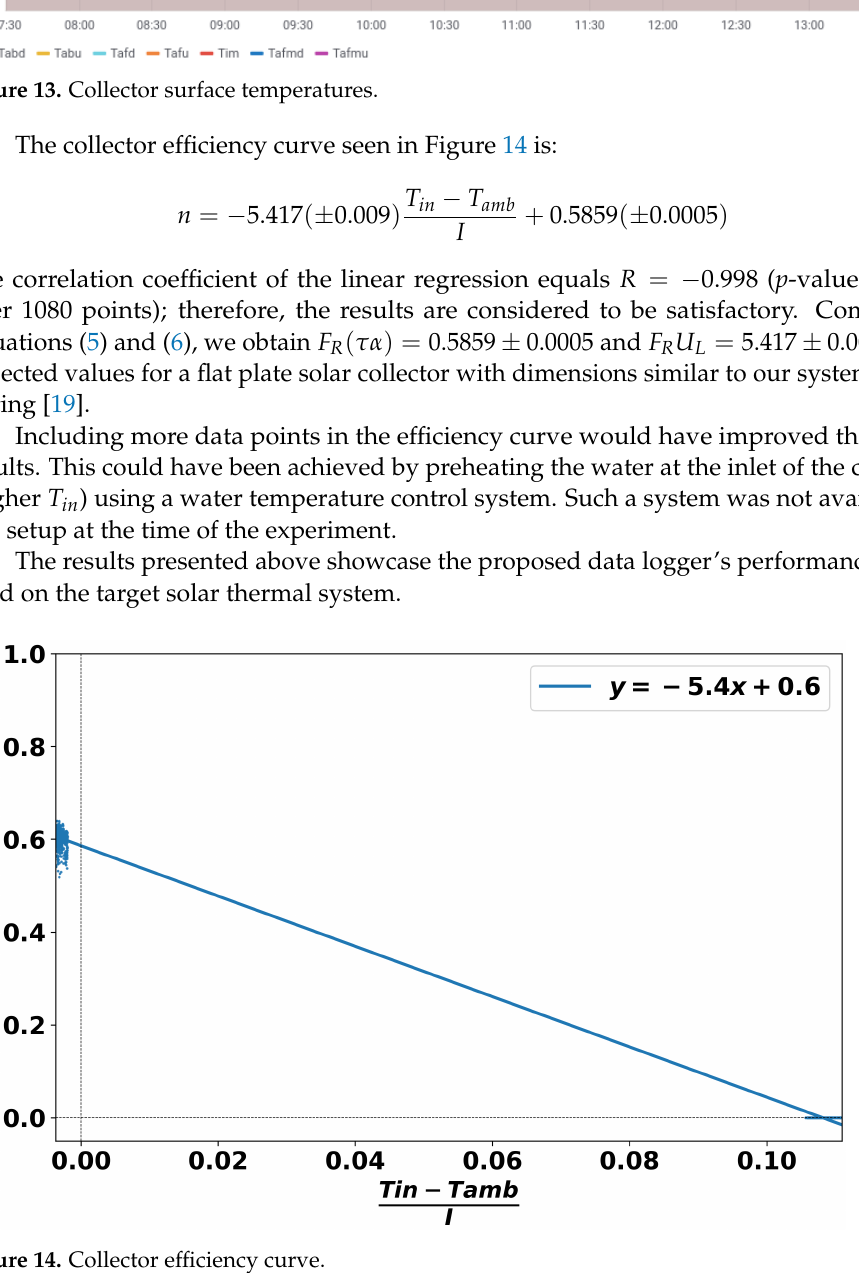
Figure 14. Collector efficiency